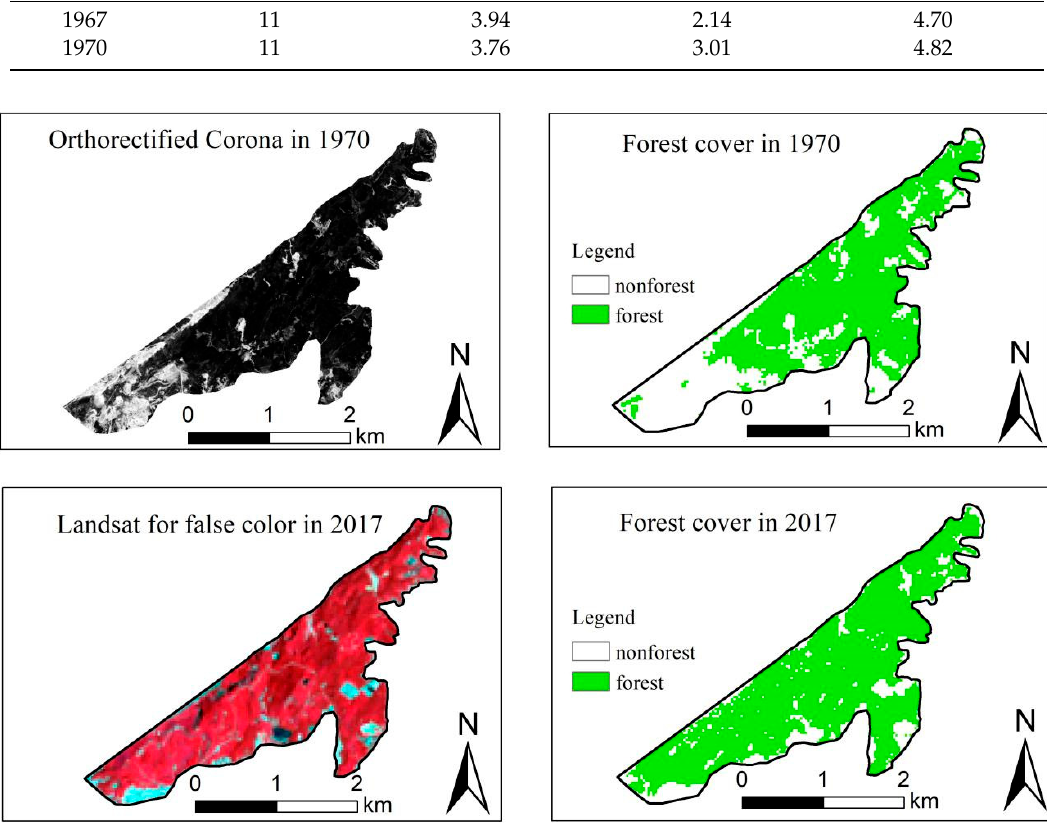
Figure 5. Ortho-rectified Corona, Landsat false color composite and derived forest cover distribution maps in 1970 and 2017.